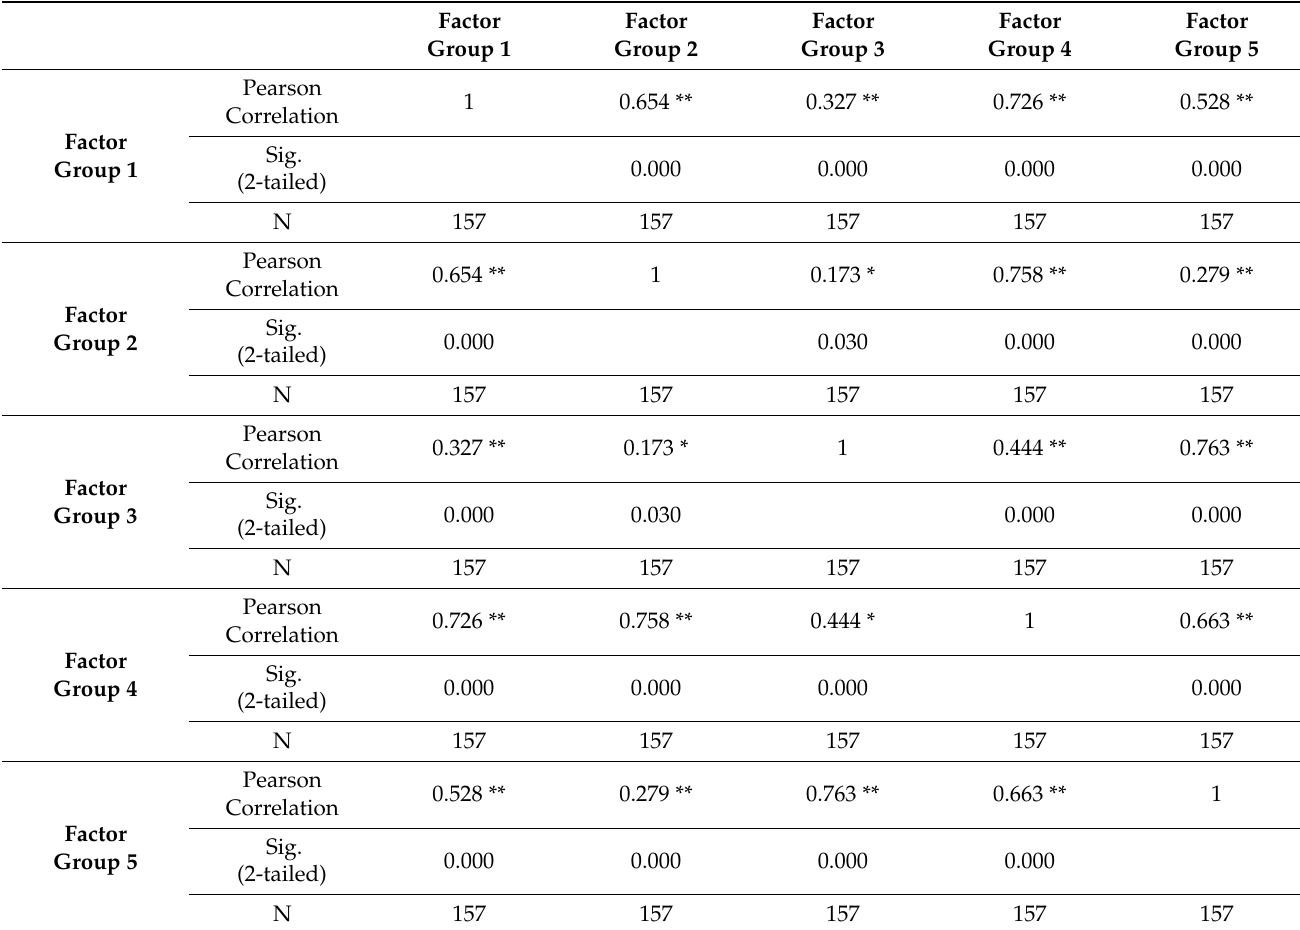
Table 6. The calculation of Pearson’s correlation. Source: composed by authors by using using IBM SPSS Statistics 26 (Armonk, NY: IBM Corp.).